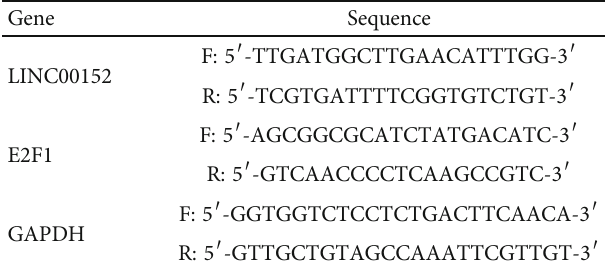
Table 1: Primers sequence of RT-qPCR. Gene